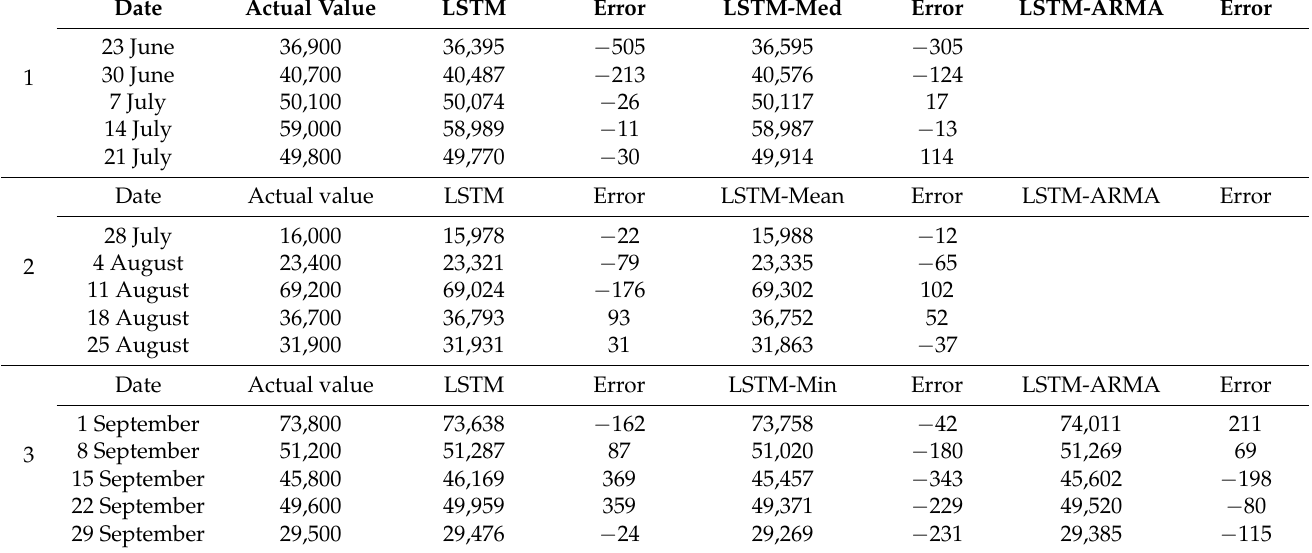
Table 7. BGA 8X13 rolling forecast results summary.